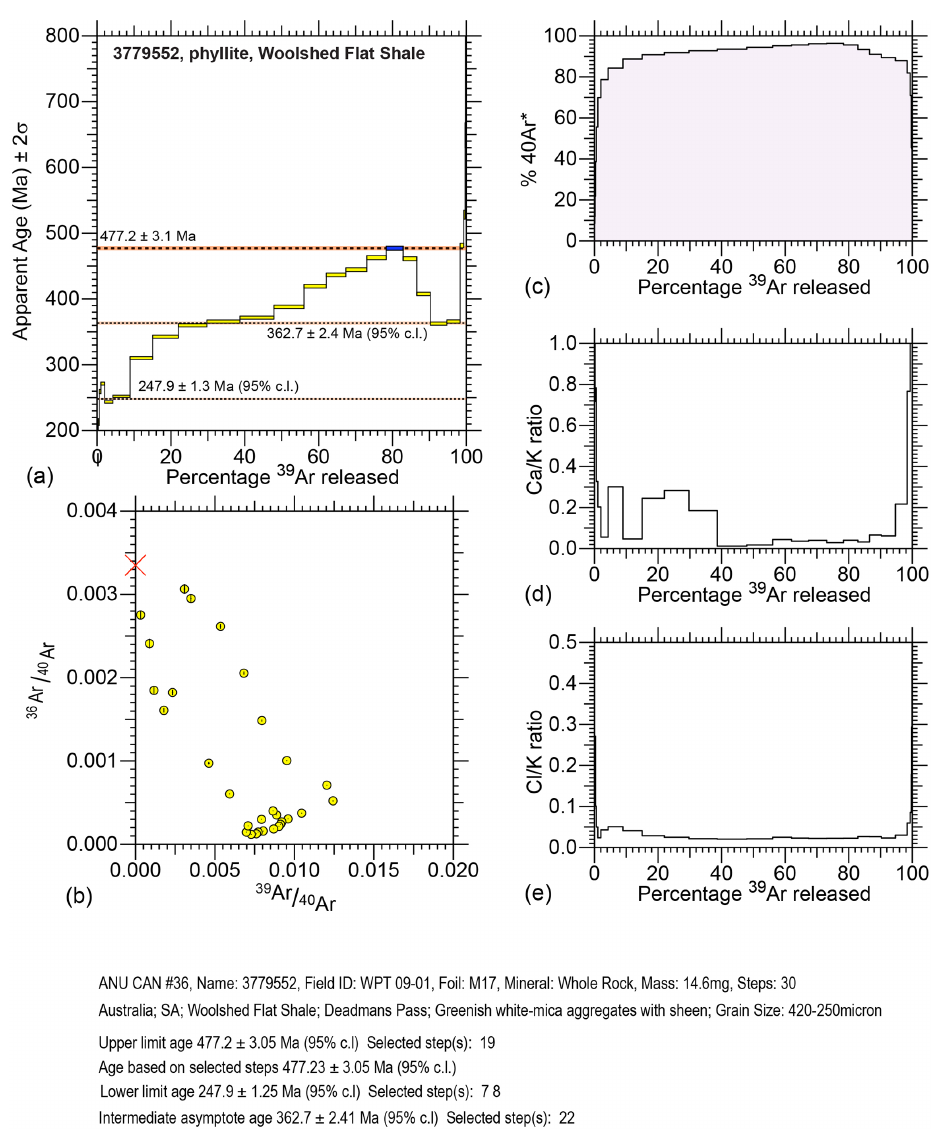
Figure C2. Sample 3779552 (a) age spectrum, (b) isotope correlation diagram, (c) percentage radiogenic 40 Ar ( 40 Ar ∗ ), (d) Ca / K ratio, and (e) Cl / K